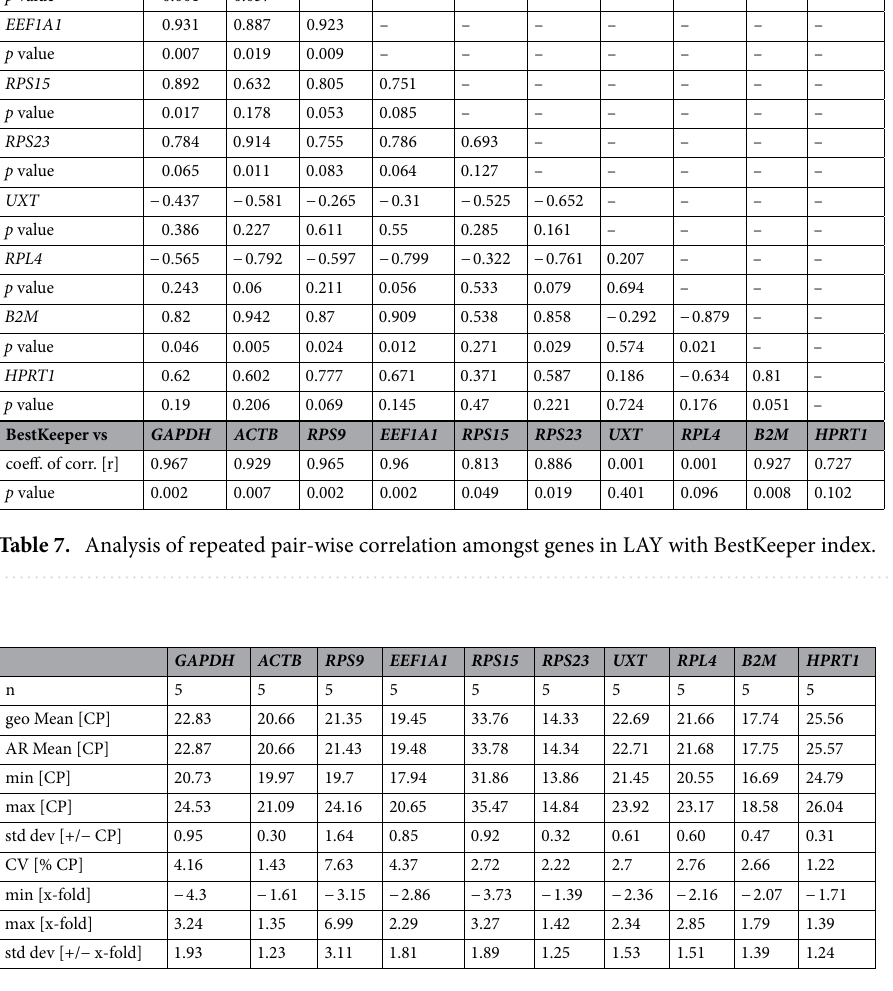
Table 8. Analysis of parameters based quantitative cycling points (CP) for 10 candidate RGs in